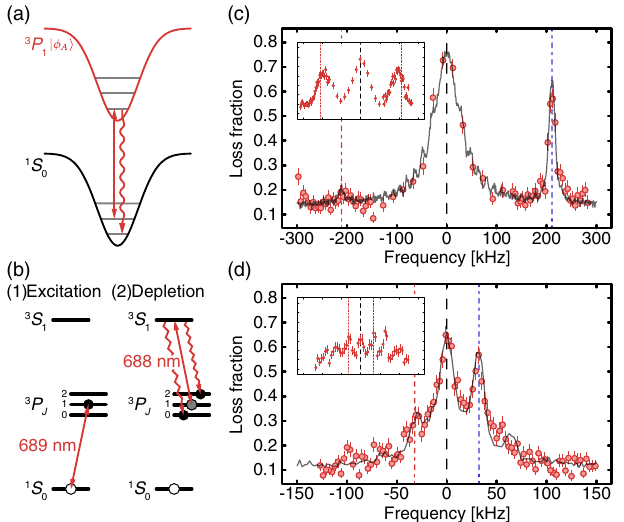
FIG. 5. Sideband cooling. (a) Diagram of the approach to resolved sideband cooling on the magic-tuned 1 S 0 ↔ 3 P 1 j ϕ transition. Optical excitation of the red sideband is spectrally resolved, and the subsequent decay conserves the motional quanta with high probability. (b) Measurement protocol for sideband spectra. Atoms in the 1 S 0 ground state are excited (solid double arrow) to the 3 P 1 excited state by an excitation pulse at 689 nm. Atoms in the 3 P 1 excited state are then excited (solid double arrow) to the 3 S 1 state by a depletion pulse at 688 nm, where they radiatively decay to the 3 P 0 and 3 P 2 metastable dark states. (c) Radial sideband spectrum before (inset) and after sideband cooling. Overlaid is a simulated spectrum with 0.80 ground-state fraction (solid gray line). The bumps visible in the simulated spectrum are Fourier peaks due to the finite 74 - μ s excitation pulse. The first radial sidebands are separated from the carrier frequency by 211(4) kHz. The amplitude of the red sideband is highly suppressed after cooling, as is the width of the blue sideband — both indicating larger ground-state fraction. (d) Axial sideband spectrum before (inset) and after the second stage of axial cooling. Overlaid is a simulated spectrum with 0.50 ground-state fraction (solid gray line). The first axial sidebands are separated from the carrier frequency by 32.2(8) kHz. Sup- pression of the red sideband and enhancement of the carrier both indicate larger ground-state